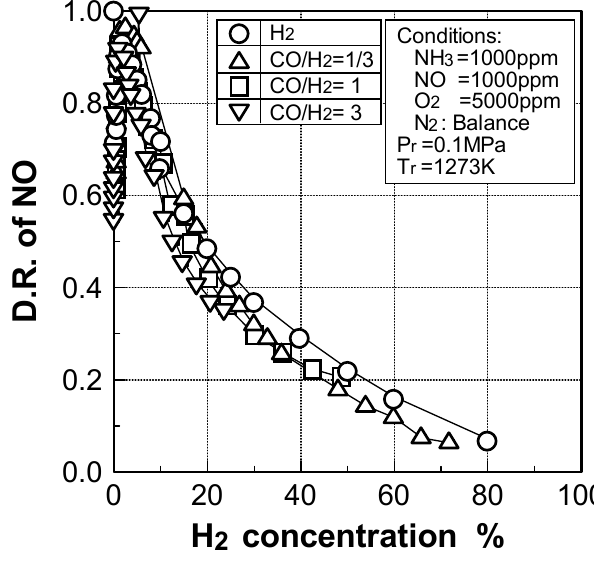
Figure 38. Relationship between decomposition ratio of NO and H combustible components as defined by